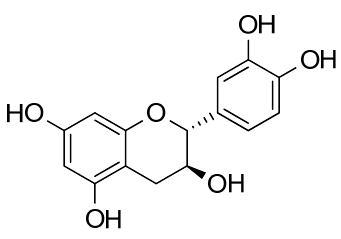
Figure 5. Structure of